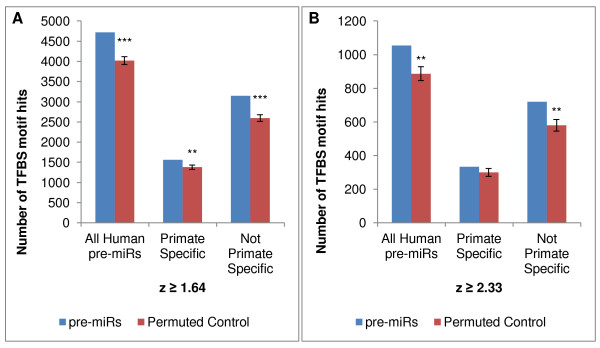
TFBS motif hits in pre-miRs as compared to permuted negative control sets. Human pre-miR sequences were scanned directly for predicted transcription factor binding sites using matrices from the TRANSFAC 7.0 Public Database at the indicated stringency (z-score ≥ 1.64 or 2.33, see Methods). For each pre-miR, a randomized negative control set was created consisting of 1,000 iterations of permuted sequences matched for length and dinucleotide frequency. Each of the randomized sequences was then scanned for TRANSFAC motif hits in the same manner. **significant at p < 3 × 10-5. ***p < 2 × 10-12.